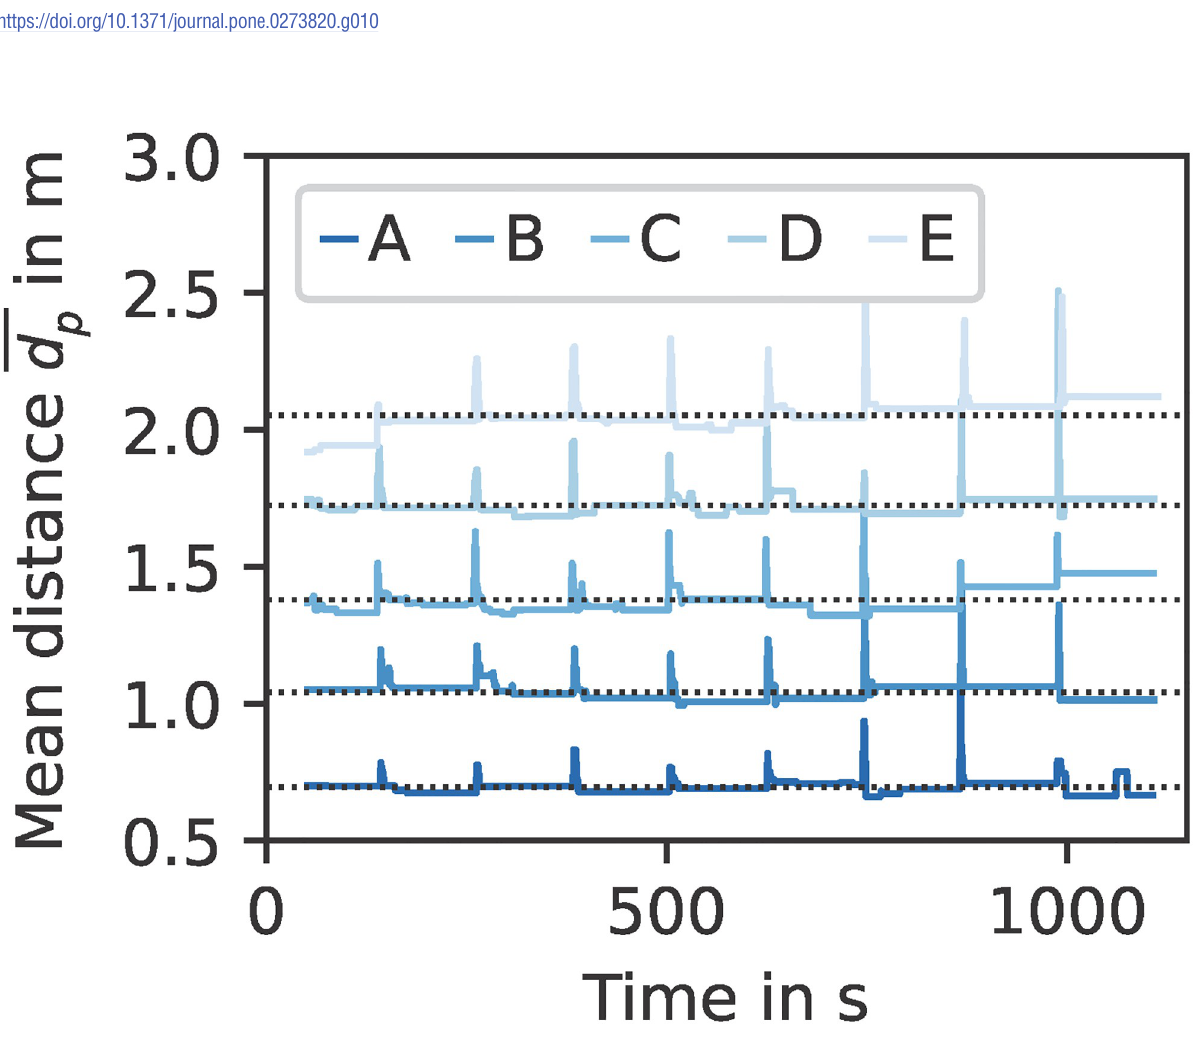
Fig 11. Distances between persons in the queue scenarios A–E over time. The mean centre-to-centre distance between queueing persons � d with potential parameter p and corridor distance d . We consider only the period t � 50 s, that is when all persons have queued up. The peaks indicate c time steps at which a person leaves the scenario and all others move up, leading temporarily to a greater mean distance. Dotted lines represent the time average of each